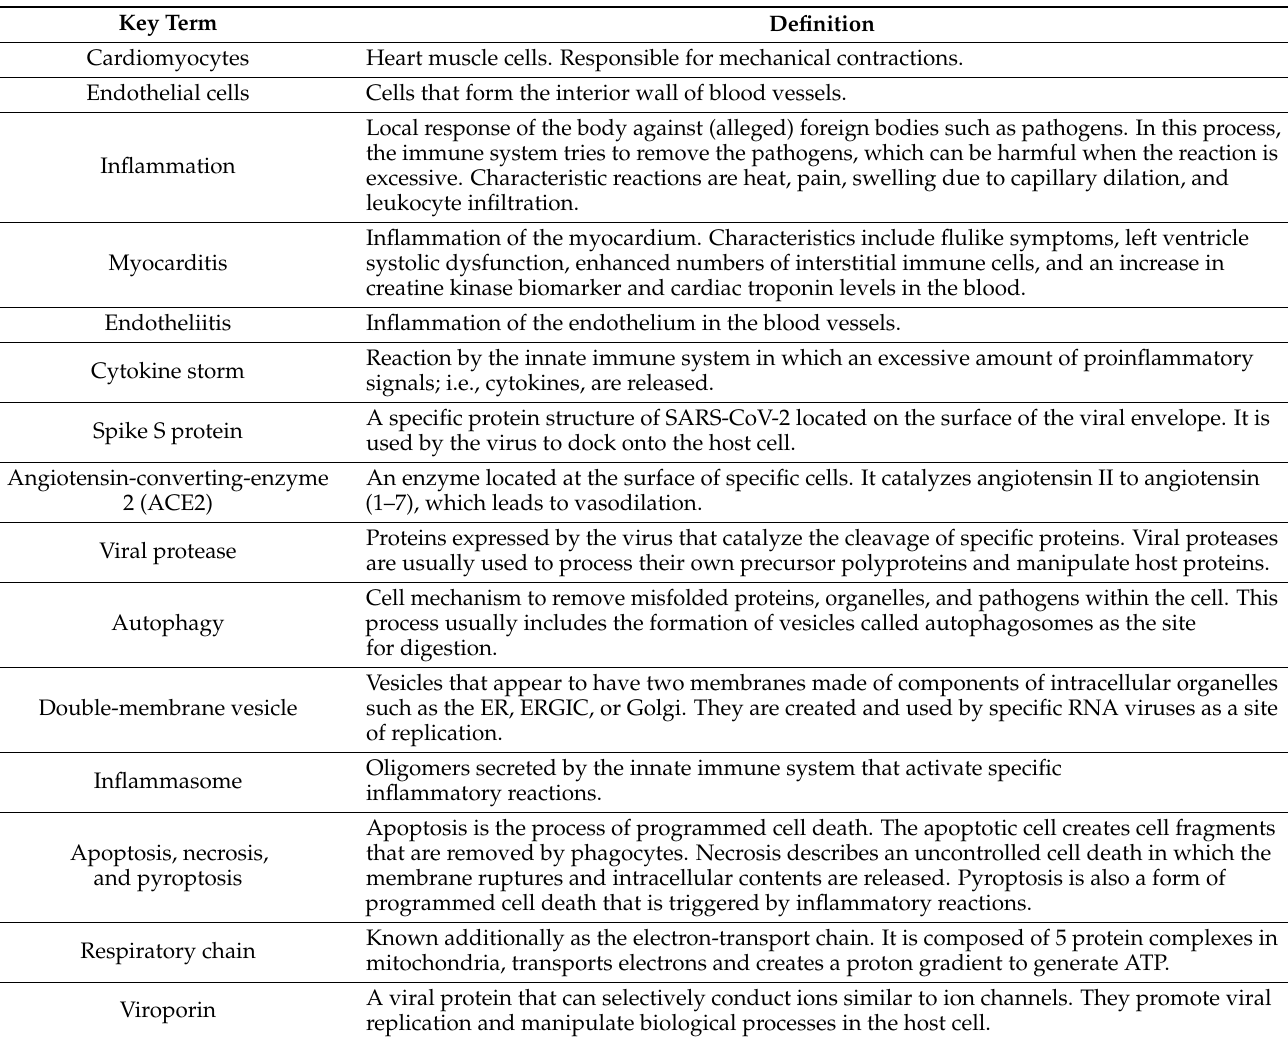
Table 1. Glossary of key terms used in this